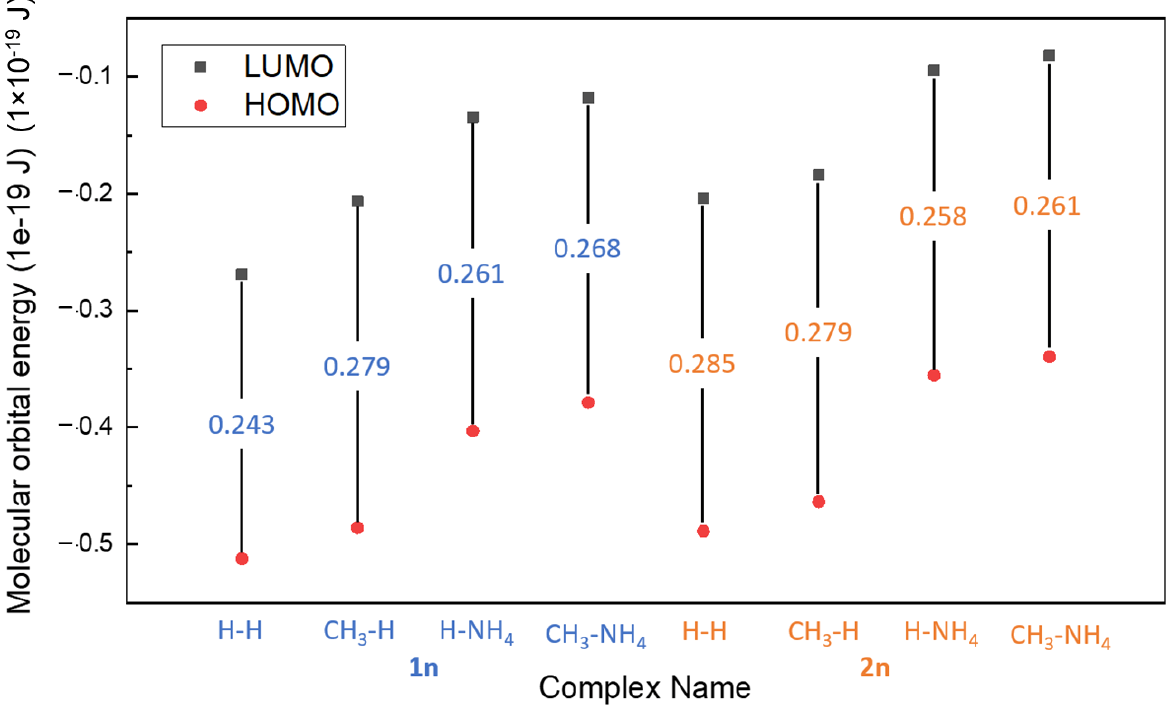
Figure 6. The HOMO-LUMO gap of different complexes. Table 3. The HOMO-LUMO gap of the optimized polymers and their corresponding Fe-complex, and the electron affinity (EA) values for the Fe-PESA complexes only. The energy values are in 1 × 10 − 19 J.